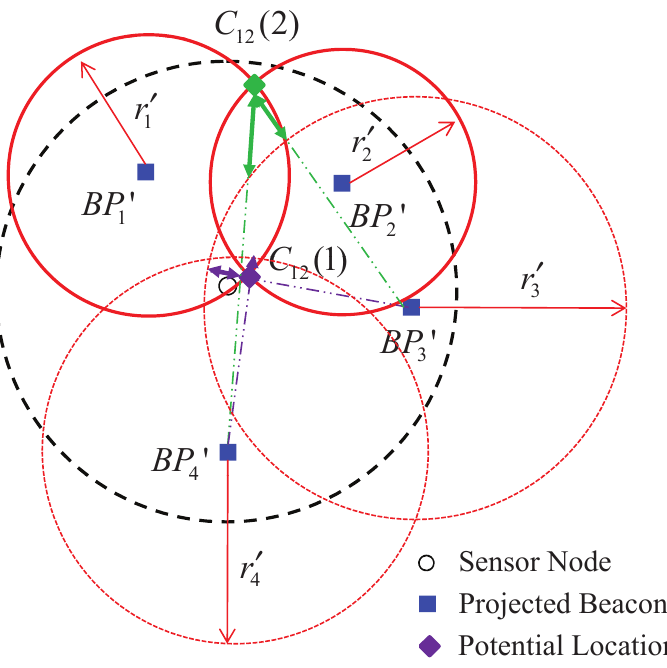
Figure 6. Selection of a potential location between two intersection